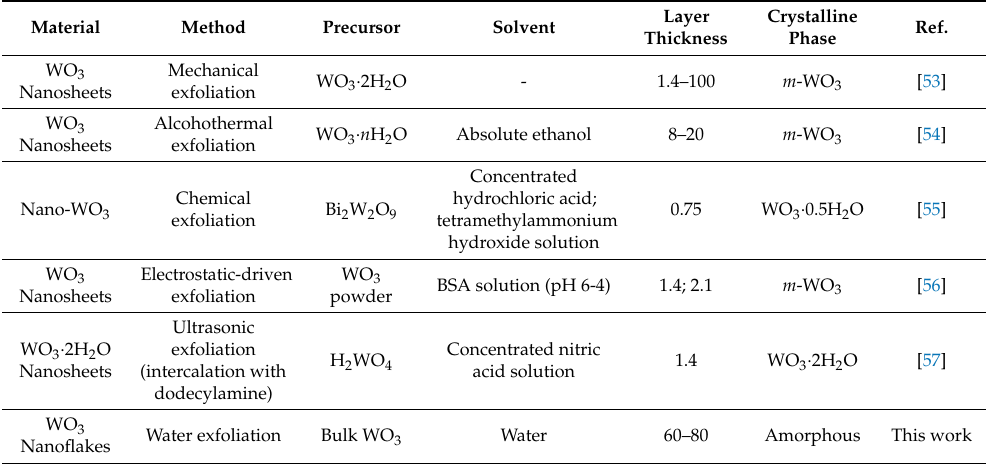
Figure 5. XRD patterns of ( a ) bulk and hydrated and non-crystalline WO 3 , ( b ) only hydrated and non- crystalline WO 3 . non-crystalline WO 3 . Table 1. Methods and characteristics of the exfoliation